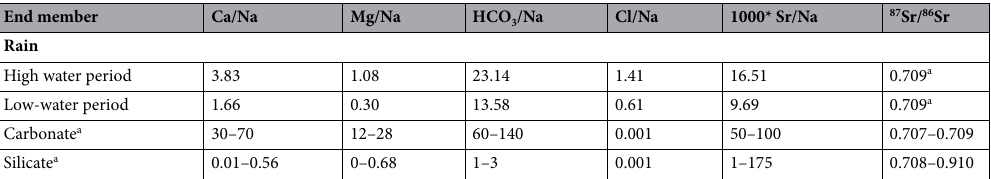
Table 1. Parameters of each model end-member. a Carbonate and silicate parameters from Millot et al. 47 , with precipitation 87 Sr/ 86 Sr ratios from Pu et al. 48 .